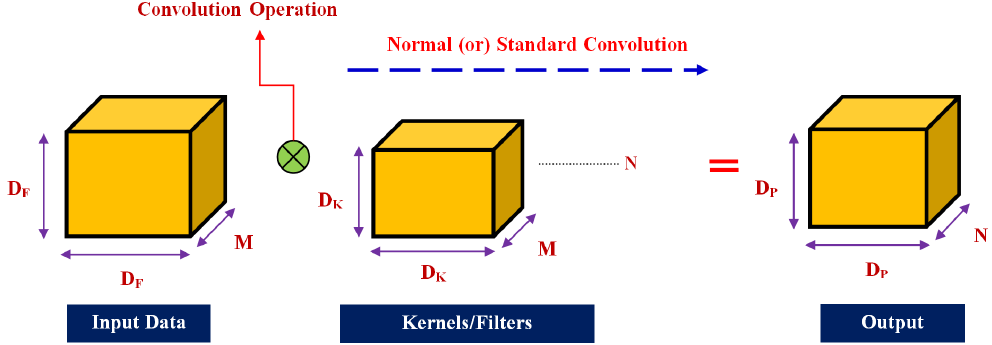
Figure 2. Standard Convolution.